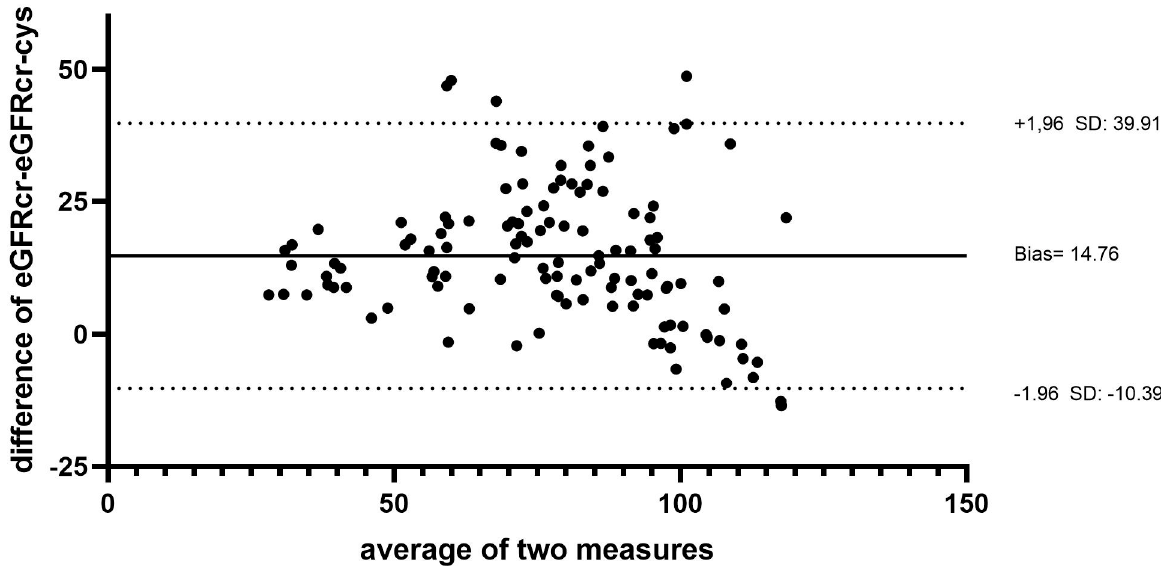
Figure 2. Difference between eGFRcr and eGFRcr-cys (Bland–Altman-Plot; 14.76 mL/min/1.73 m 2 ). SD denotes the standard deviation of the differences between two measurements.